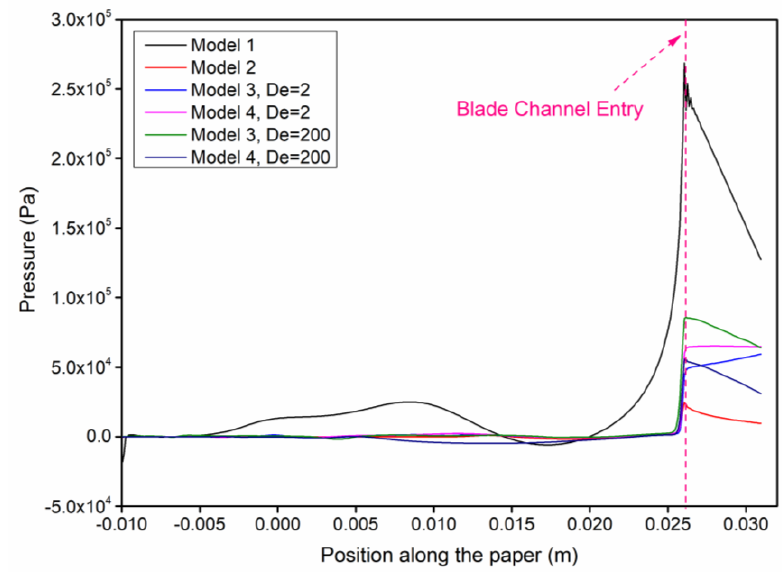
Figure 9. Pressure distribution along the surface of the paper.